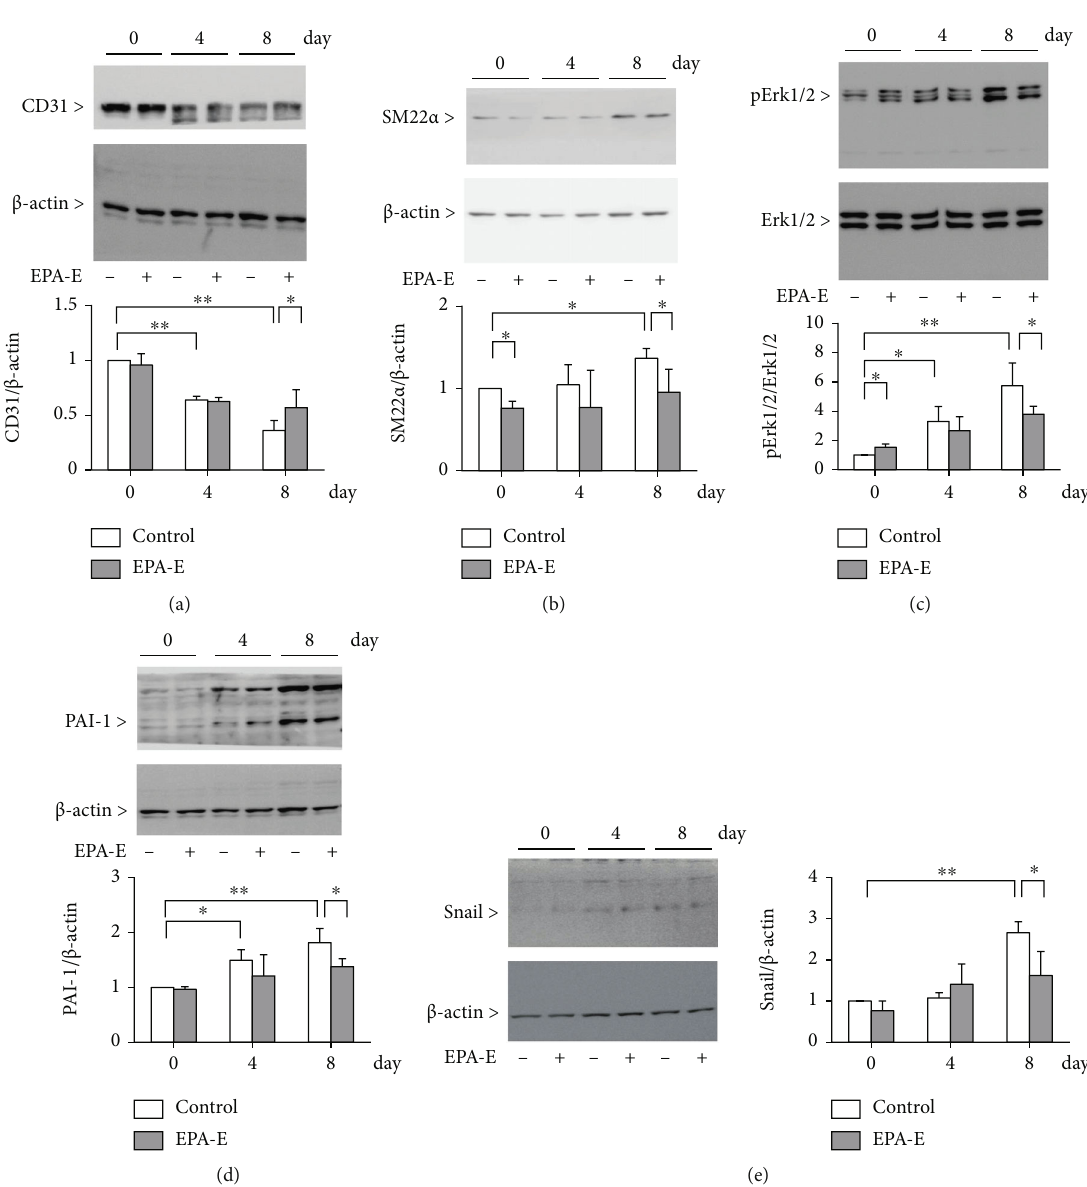
Figure 4: EPA-E decreased the adipogenic di ff erentiation medium induced-End-MT. Immunoblot analysis of CD31, SM22 α , phosphorylation of Erk1/2, PAI-1, and Snail. Endothelial cells were incubated in the adipocyte conditioned medium with or without EPA-E (200 μ M). (a) CD31. (b) SM22 α . (c) Phosphorylation of Erk1/2. (d) PAI-1. (e) Snail. ∗ P < 0 : 05 . ∗∗ P < 0 : 01 . These data are expressed as means ± SD . Regarding immunoblot, membranes are cut prior to hybridization with antibodies, so these are not images of full-length